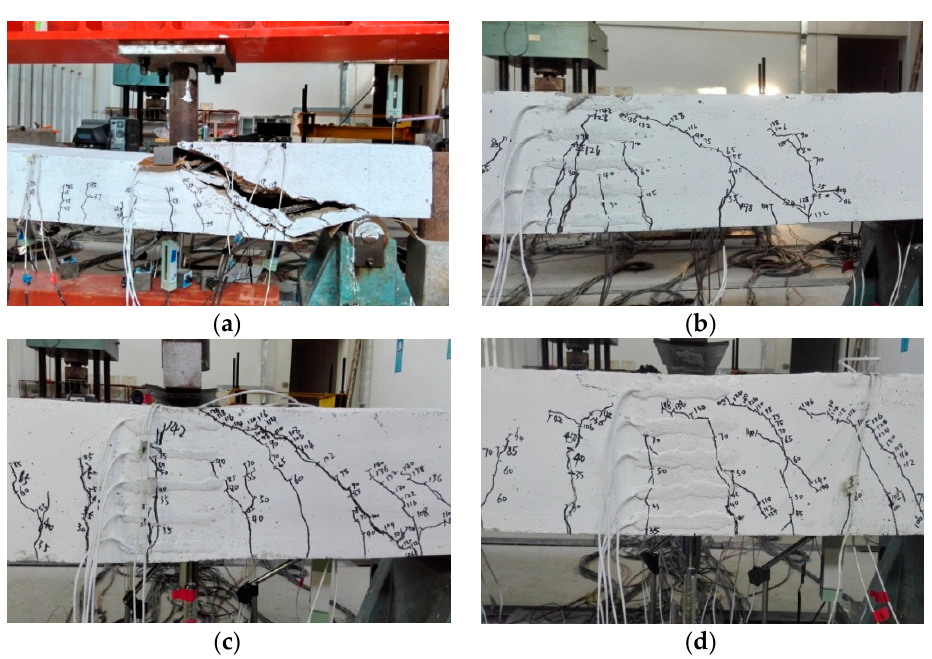
Figure 10. Comparisons of failure modes in the strengthened test slabs and unstrengthened test slabs. ( a ) S-Con; ( b ) S-C-2-9; ( c ) S-C-1-9; ( d ) S-C-1-13.